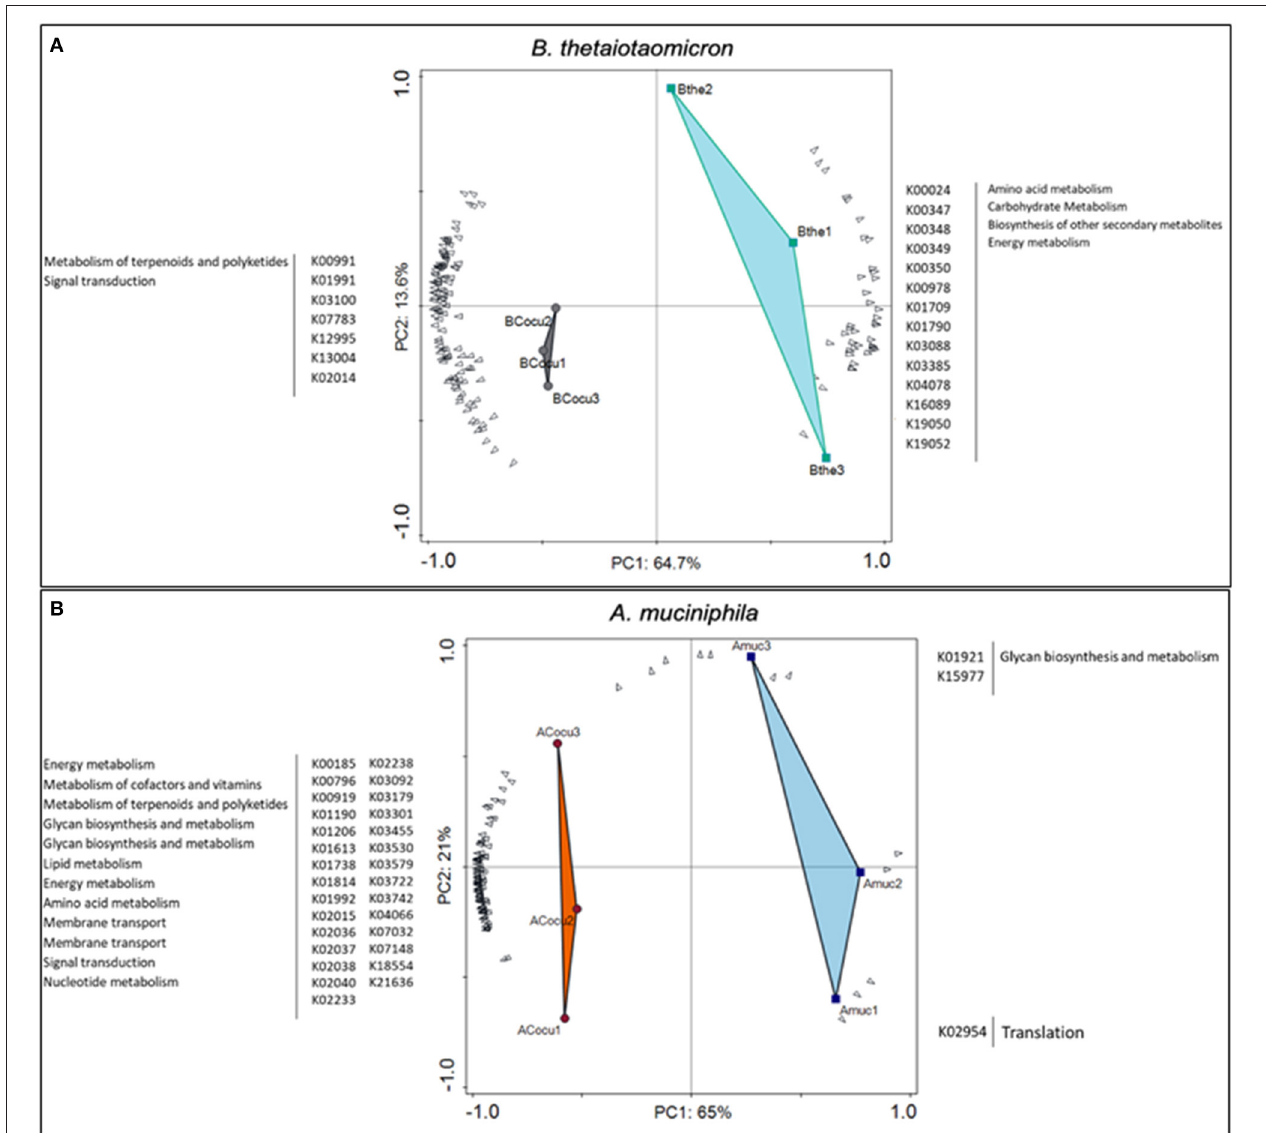
FIGURE 4 | Differential expressed genes and KEGG Orthologies (KOs) of B. thetaiotaomicron and A. muciniphila between mono- and co-culture during in vitro fermentation. (A) Principal Component analysis (PCA) showing the most variable KOs between B. thetaiotaomicron mono- and co-culture. (B) Principal Component analysis (PCA) showing the most variable KOs between A. muciniphila mono- and